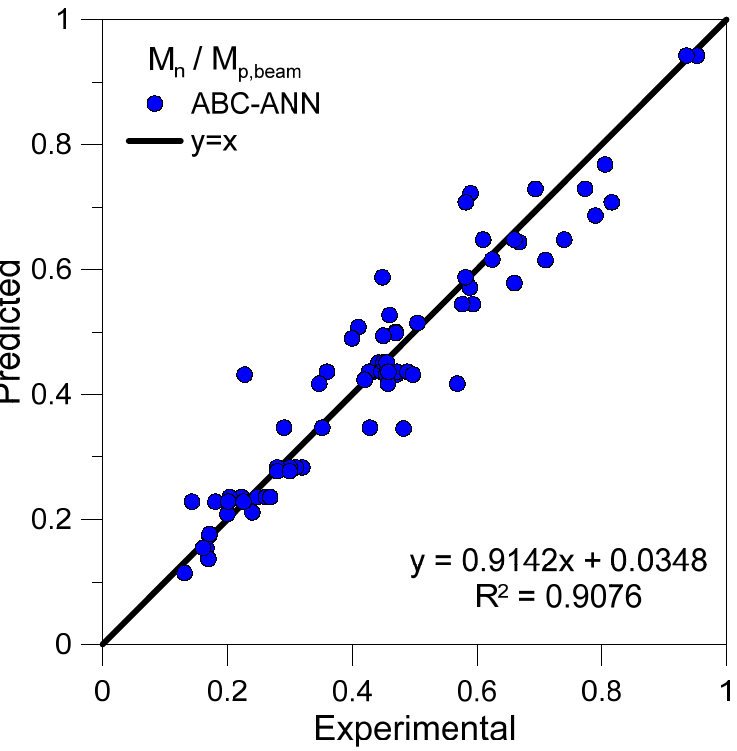
Figure 9. ABC-ANN calculated versus experimentally observed values for the parameter ( M n /M p,beam ).